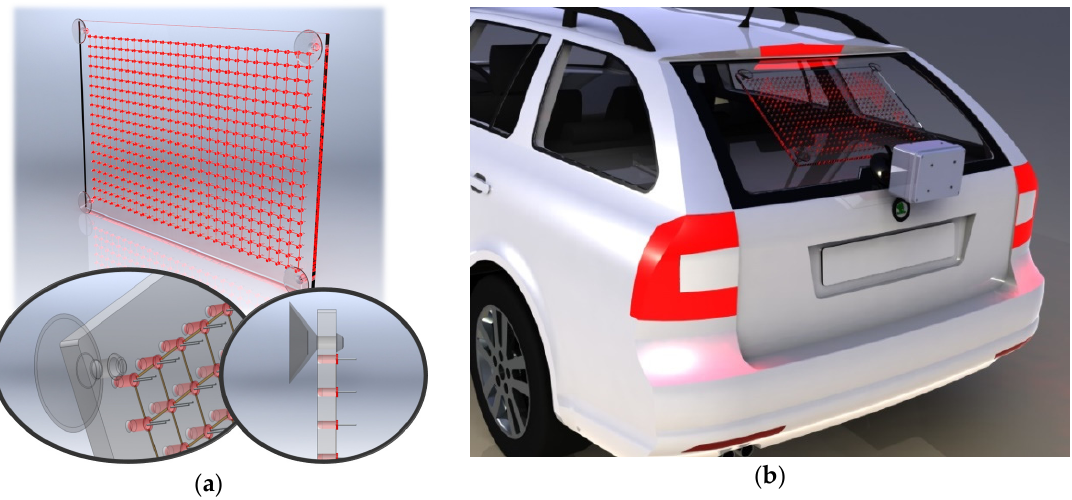
Figure 11. Model of the proposed transparent display design. ( a ) LED-matrix detail; ( b ) mounting on the rear window of a vehicle.